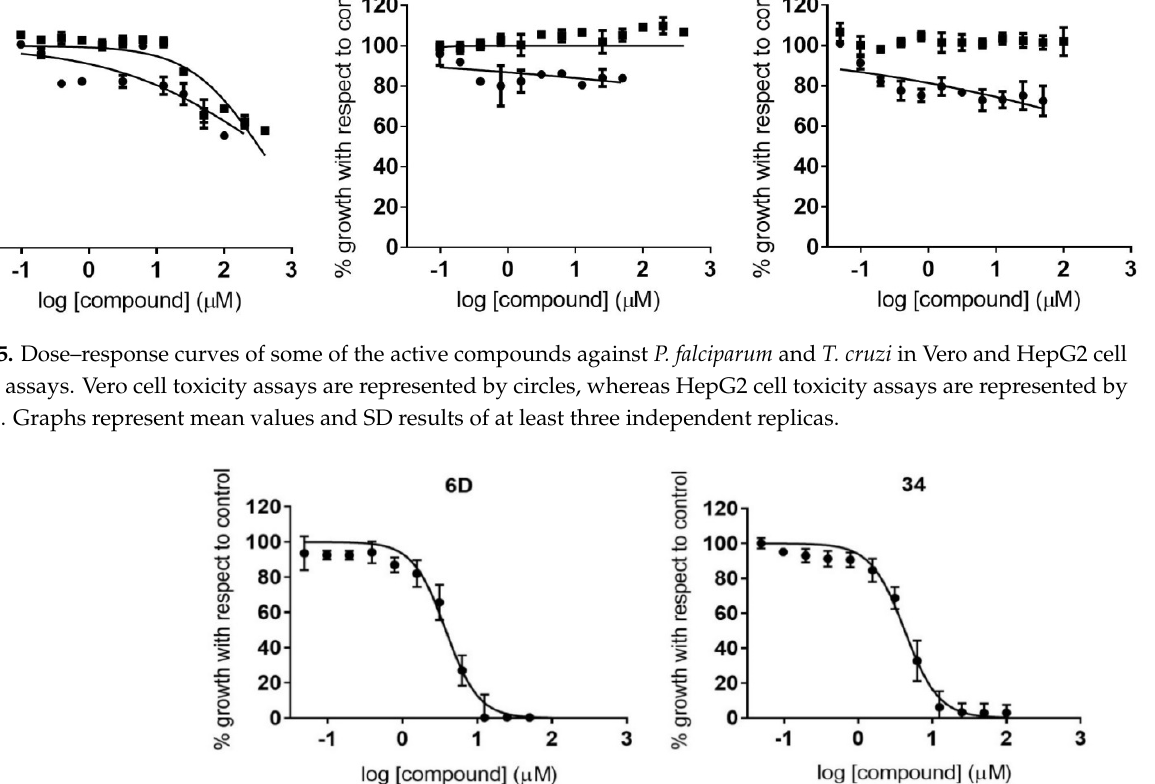
Table 2. IC 50 (µM), TC 50 (µM), and SI values of active compounds against P. falciparum and T. cruzi . Figure 6. Dose–response curves of compounds with specific antiamastigote activity. Graphs represent mean values and SD results of at least three independent replicas.